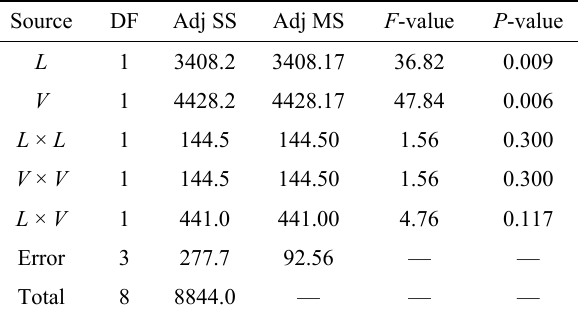
Table 8 Analysis of variance for S al .